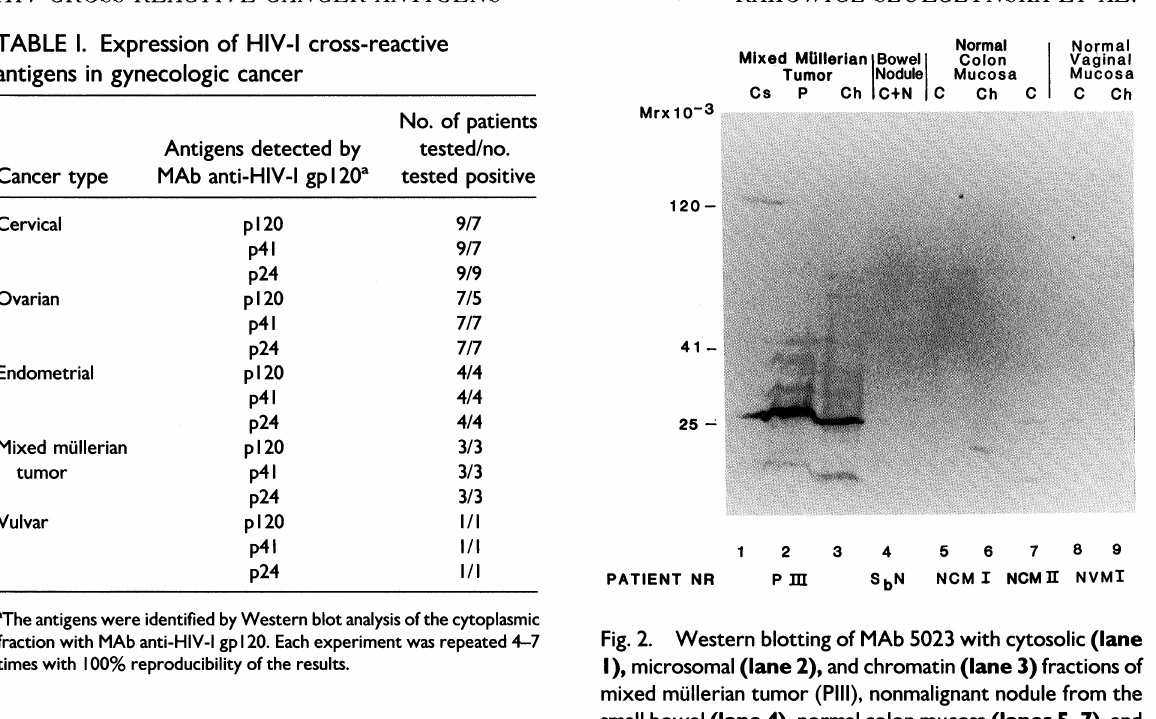
TABLE I. Expression of HIV-I cross-reactive